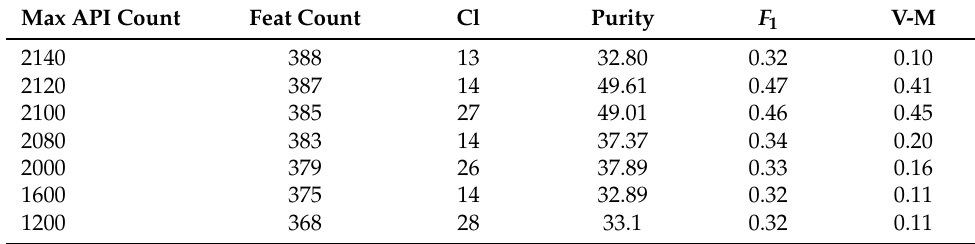
Table 3. Data Set 1C exclusion of high-frequency features.